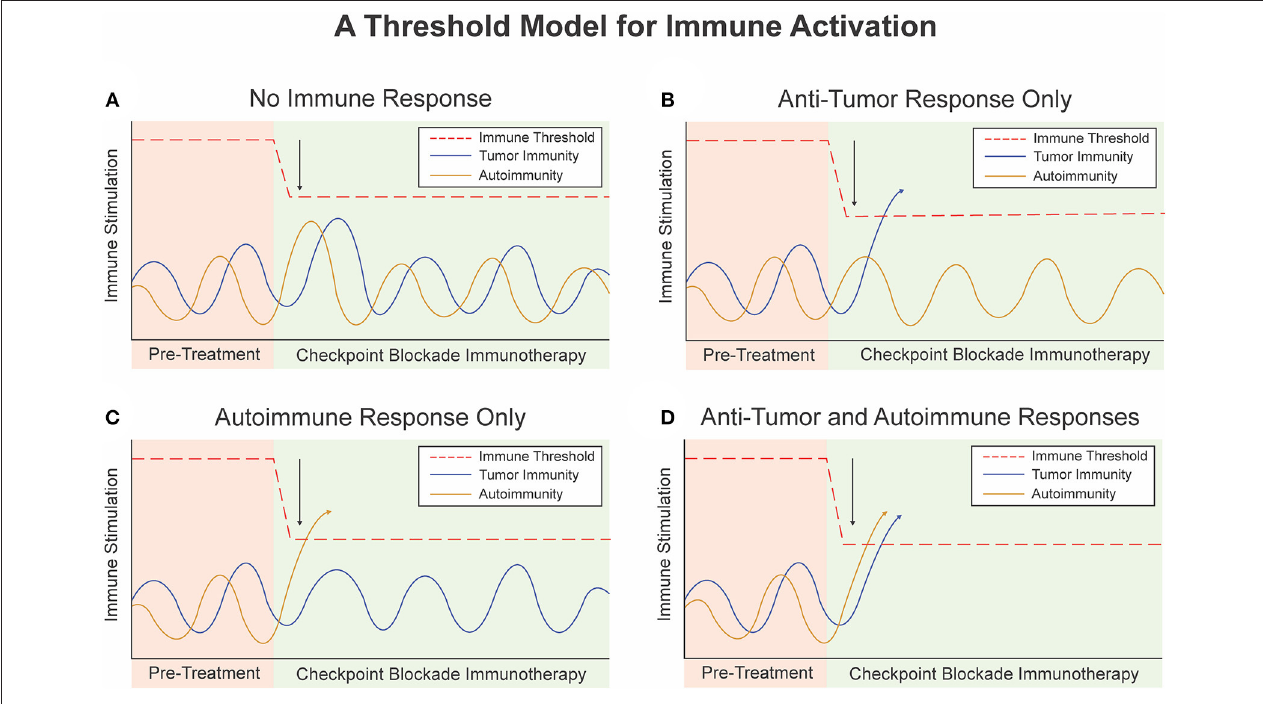
FIGURE 2 | A threshold model for immune activation. (A) Checkpoint Blockade Immunotherapy (CBI) lowers the threshold for immune activation but not enough to trigger an immune response. (B) CBI lowers the threshold for immune activation to trigger an anti-tumor immune response but not an auto-immune response. (C) Baseline immunity to self antigens is higher than immunity to tumor associated antigens. CBI lowers the threshold to induce an auto-immune response but no anti-tumor immune response or immune-related adverse event. (D) Single agent or dual agent CBI lowers the threshold for immune activation to trigger an anti-tumor immune response and an auto-immune response or immune-related adverse